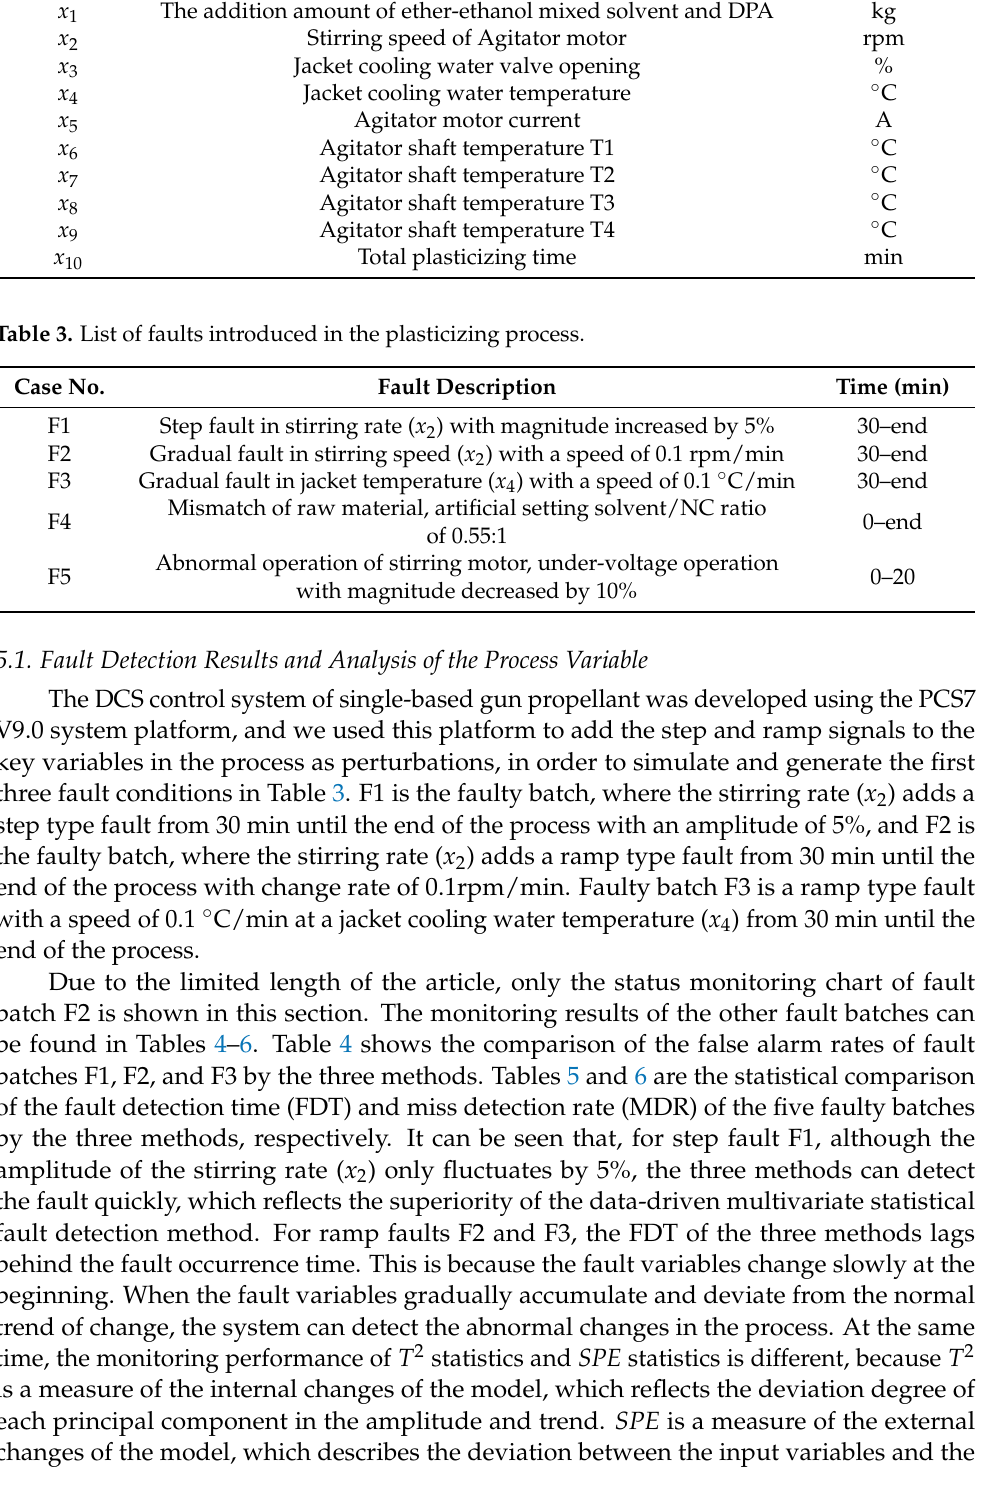
Table 2. Process variables for the modelling of the plasticizing process. No.